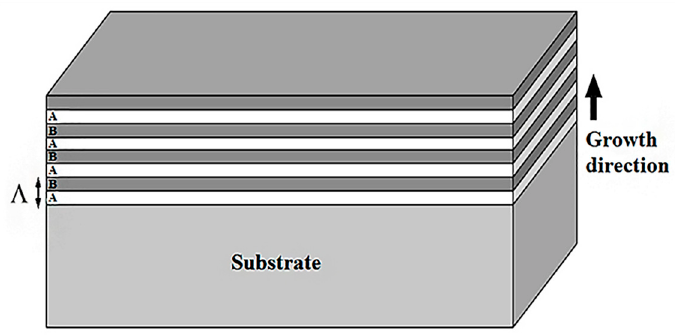
Figure 2. Schematic architecture of a multilayer coating.